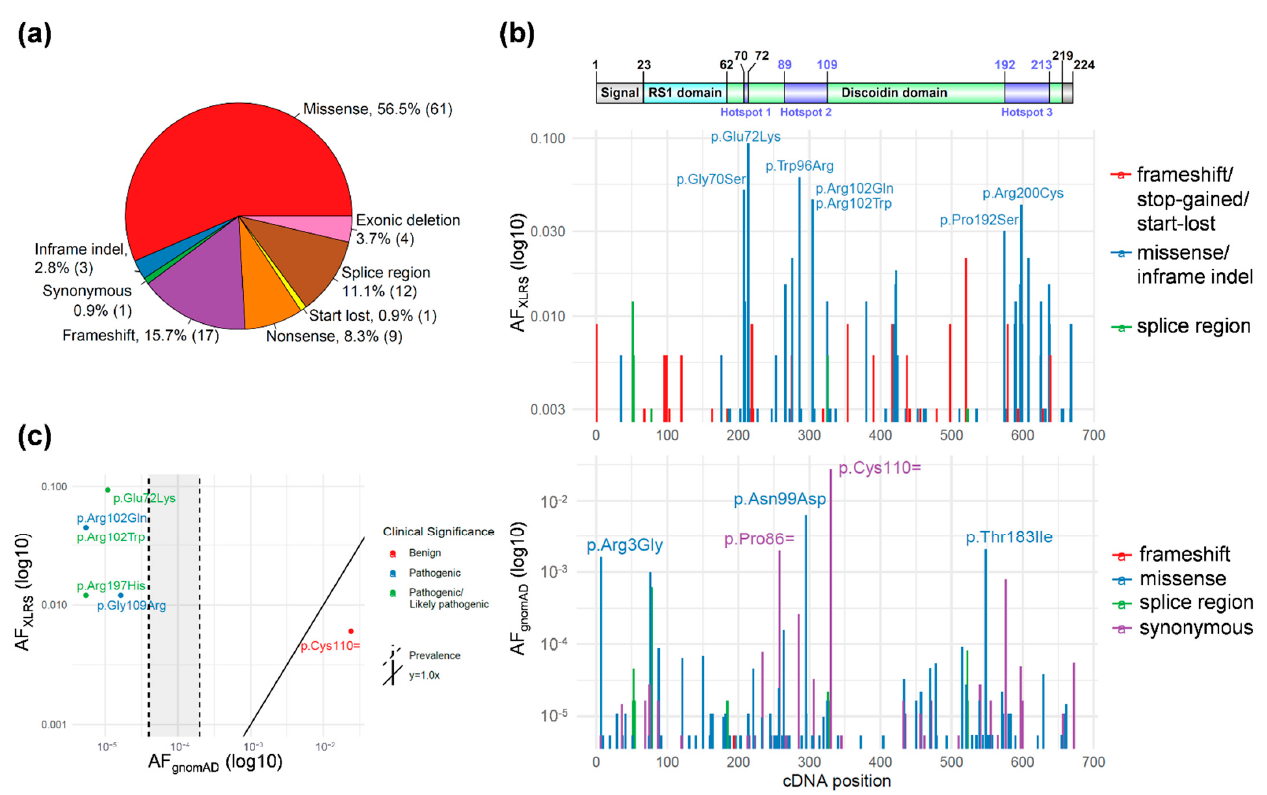
Figure 1. RS1 variant types and localizations in the XLRS cohort and gnomAD. ( a ) Variant type distribution in the XLRS cohort. ( b ) RS1 protein domains (Top) and variant allele frequencies (AF) along the cDNA position in the XLRS cohort (middle) and gnomAD (bottom). The splice region variants in the XLRS cohort include intronic variants reported in clinical reports. The splice region variants in the gnomAD dataset include intronic variants in ±3–8 nucleotides from the exon–intron junctions. The gnomAD v2.1.1 dataset does not contain any variants in the ±2 canonical splicing sites. Variants denoted are those with AF > 0.03 in XLRS or >0.001 in gnomAD. ( c ) Allele frequencies for variants present in both XLRS cohort and gnomAD. Shaded: the XLRS prevalence of 1 in 5000 to 1 in 25,000 males.